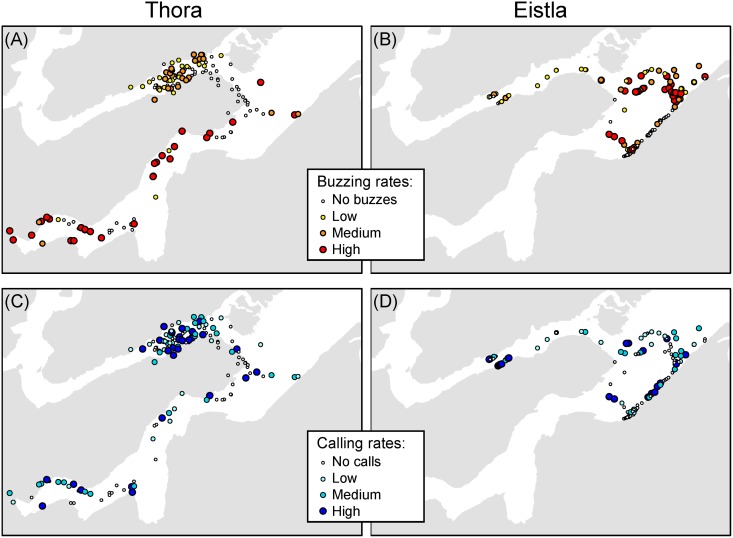
Buzzing and calling rates as a function of location for females Thora and Eistla.Locations devoid of buzzes or calls are shown as white circles. Locations with associated sound production are shown with increasingly darker and larger symbols, in a red color scheme for buzzes [panels (A) and (B)] and a blue color scheme for calls [panels (C) and (D)]. The three sound production categories were limited by the 33rd and 66th percentiles of the buzzing or calling rate for each female, with Low < 33rd percentile, Medium > 33rd and ≤ 66th percentile, and High > 66th percentile. These percentiles were as follows—Thora (left panels): 33rd = 0.39 buzzes / min and 0.22 calls / min, 66th = 0.96 buzzes / min and 0.64 calls / min; Eistla (right panels): 33rd = 0.69 buzzes / min and 0.10 calls / min, 66th = 1.01 buzzes / min and 0.33 calls / min.